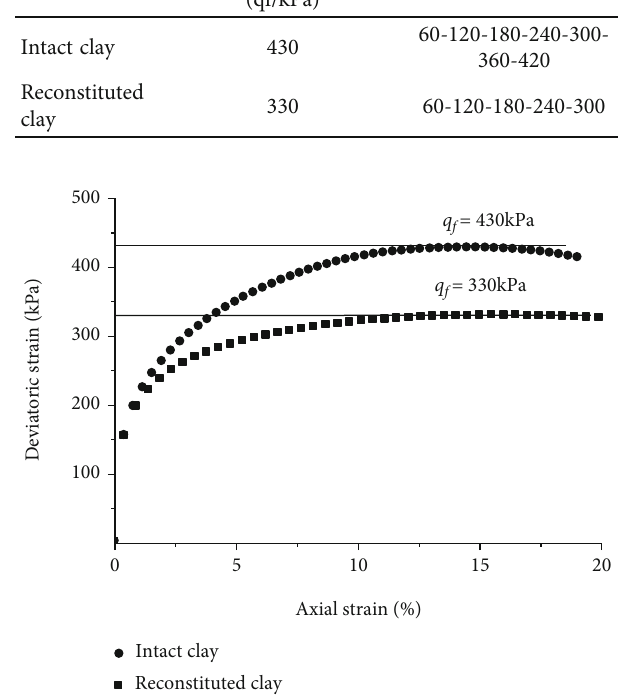
Figure 2: Triaxial consolidation undrained (CU) test.